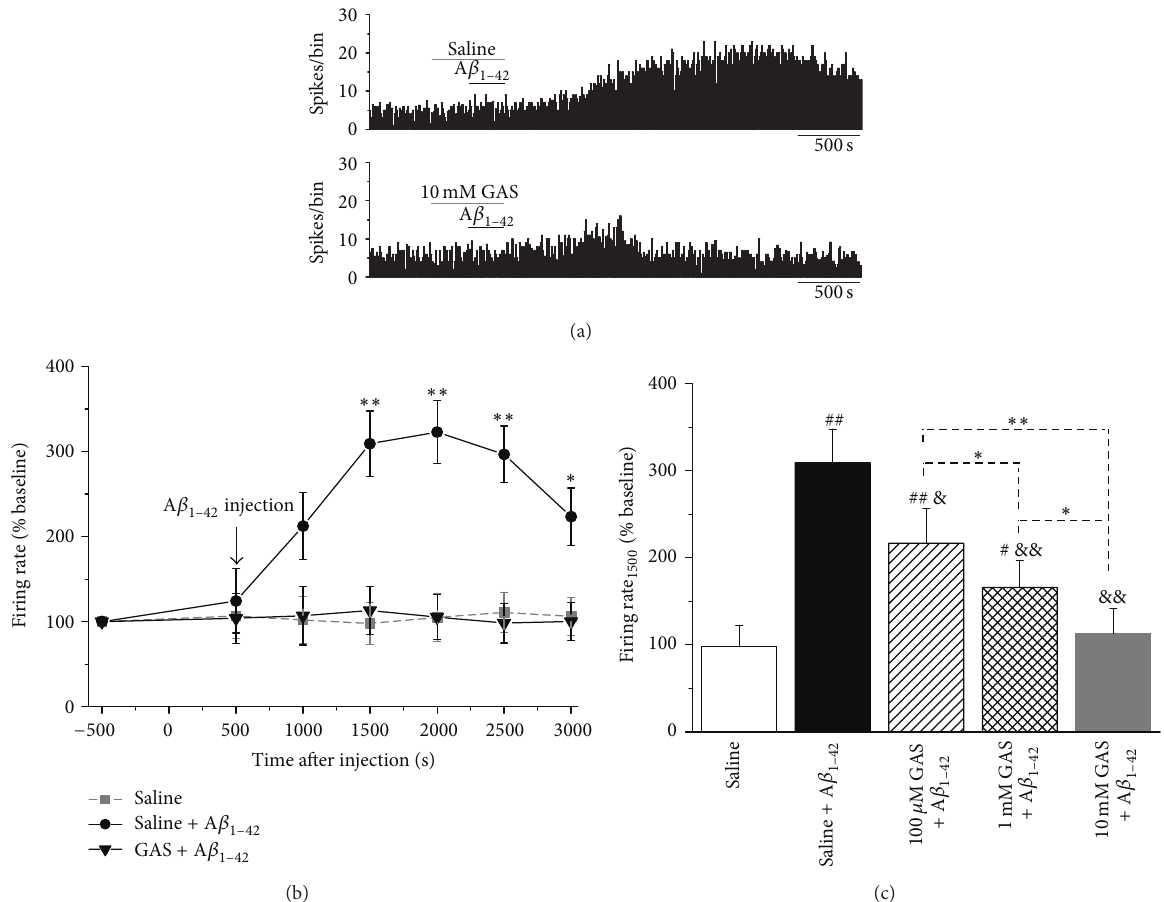
Figure 5: GAS pretreatment inhibited A 𝛽 1 -induced increase in firing rate of EC neurons in a concentration-dependent manner. (a) – 42 -induced increase in firing rate of EC neurons, Representative traces show that pretreatment with 10mM GAS (lower) prevented the A 𝛽 1 – 42 -induced changes of firing rate in EC neurons, pretreated whereas saline (upper) had no obvious effect. (b) Time-response curves of A 𝛽 1 – 42 with saline or 10 mM GAS ( ∗ 𝑃 < 0.05 , ∗∗ 𝑃 < 0.01 versus baseline values (500 s before saline or GAS injection)). (c) Concentration-dependent inhibitory effects of GAS on A 𝛽 1 -induced firing rate changes ( # 𝑃 < 0.05 , ## 𝑃 < 0.01 versus saline alone group, & 𝑃 < 0.05 , && 𝑃 < 0.01 – 42 group, ∗ 𝑃 < 0.05 , ∗∗ 𝑃 < 0.01 versus saline plus A 𝛽 1 – 42